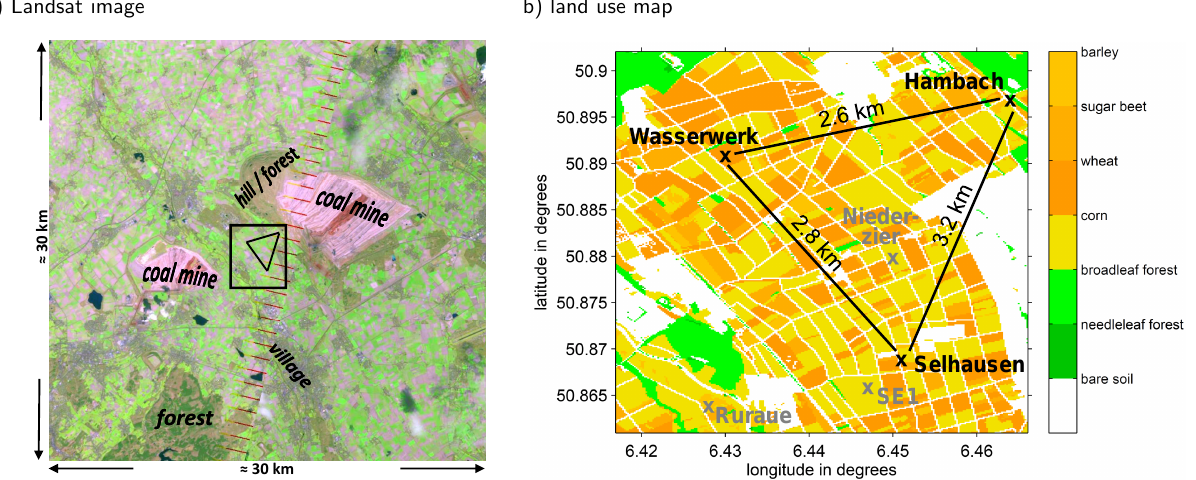
Figure 1. (a) Landsat false color image (composite of infrared and visible bands) from 24 April 2013 (available from the US Geological Survey at landsatlook.usgs.gov); the black rectangle denotes the sector shown in (b) ; additionally, characteristic topographic features are marked; (b) land-use classification with positions of energy balance stations and lidars at Hambach and Wasserwerk and of the lidar at Selhausen (black crosses) as well as of the TERENO energy balance stations at Ruraue, near Selhausen (SE1), and at Niederzier (gray crosses); black lines denote the relative lidar